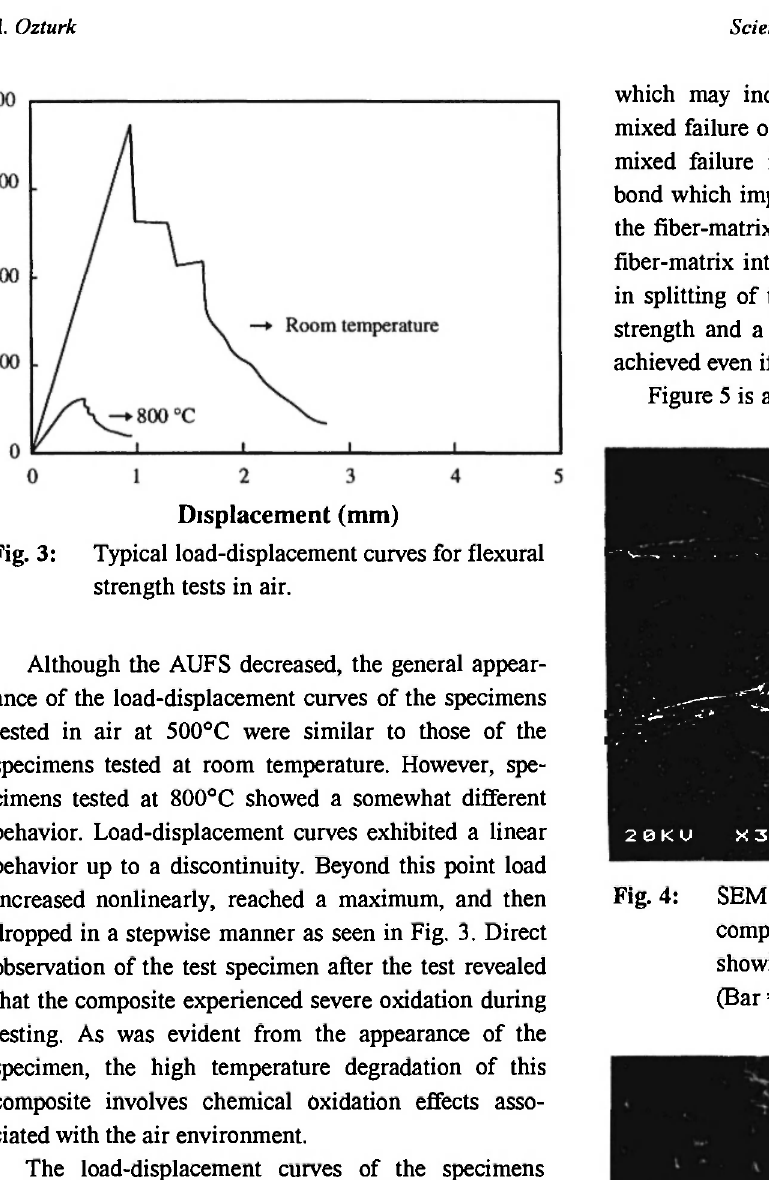
Fig. 3: Typical load-displacement curves for flexural strength tests in air.